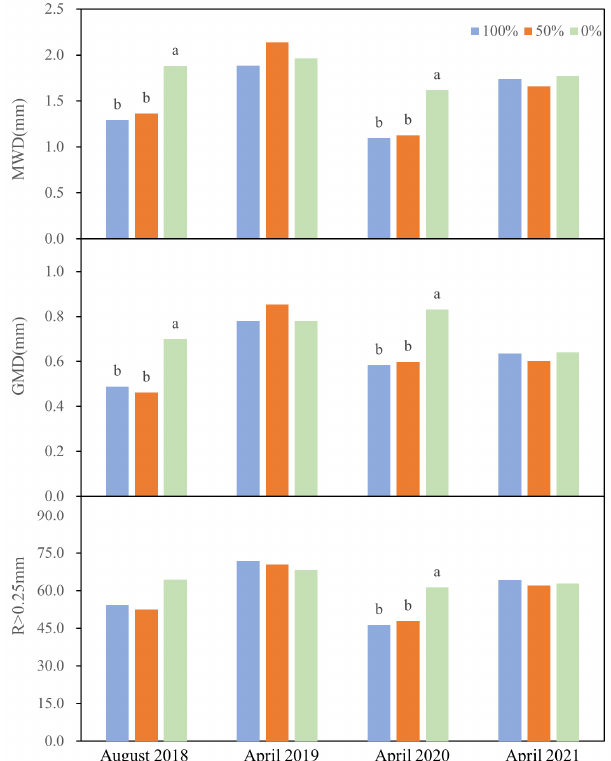
Figure 3. Effects of crop residue removal rates on soil aggregate characteristics. The bars show the distribution of soil aggregates by size, mean weight diameter ( MWD ), geometric mean diameter ( GMD ), and percentage of aggregates larger than 0.25 mm ( R > 0.25 mm ). The lowercase letters indicate significant differences among treatments within each sampling period ( p < 0.05). No letters indicate no significant differences. The numbers 0%, 50%, and 100% represent the crop residue removal rates for each treatment.